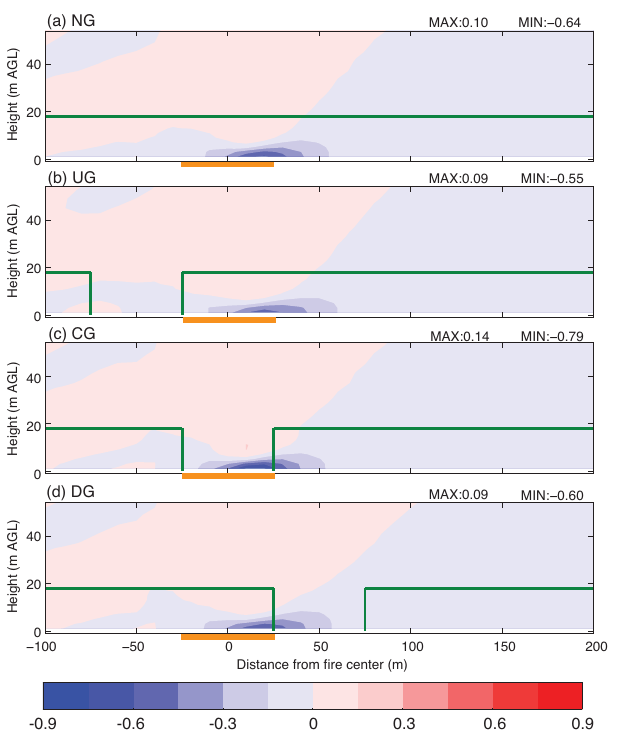
Figure 6. As in Fig. 2 but for the vertical gradient of the vertical turbulent heat flux (Ks − 1 ); shading interval: 0.15Ks − 1 . The no- fire case is omitted due to small values relative to fire case.